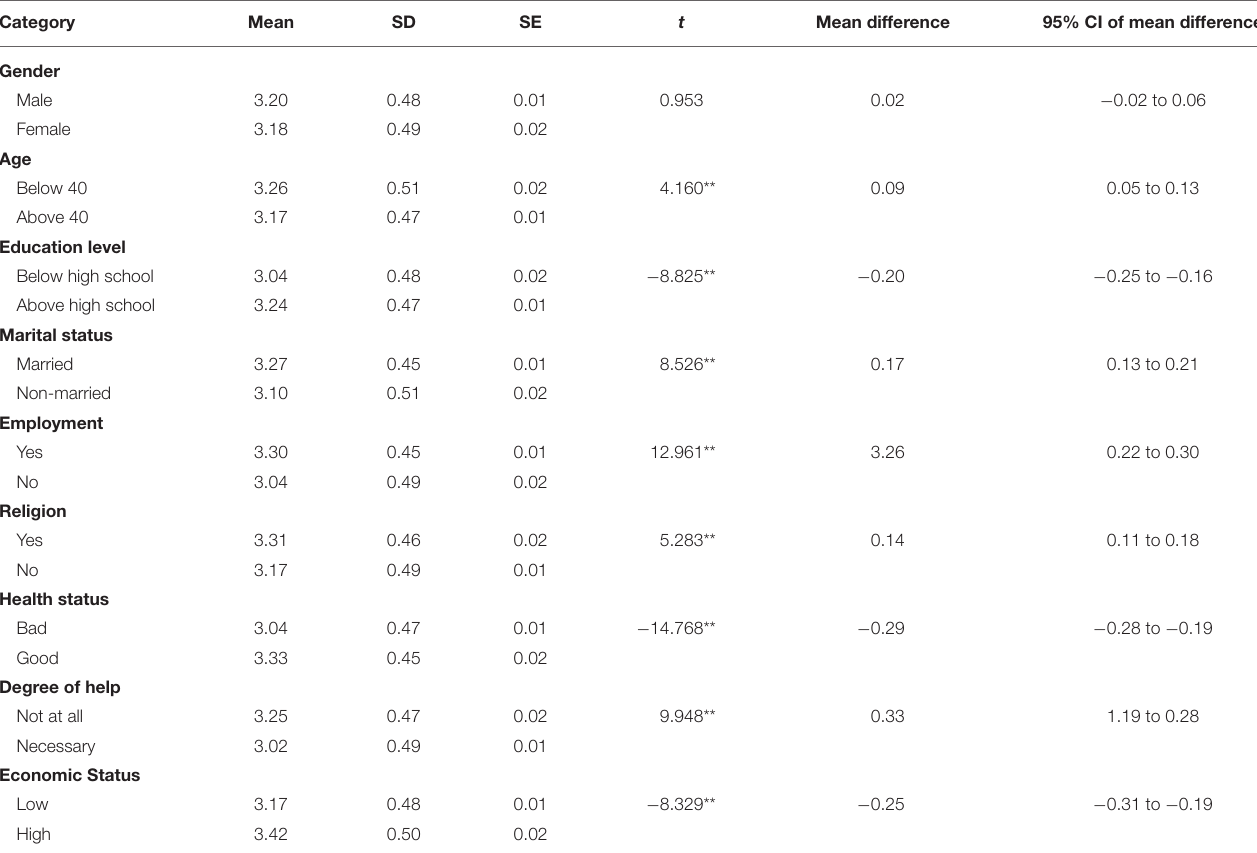
TABLE 2 | The differences of acceptance of disability according to socio-demographic